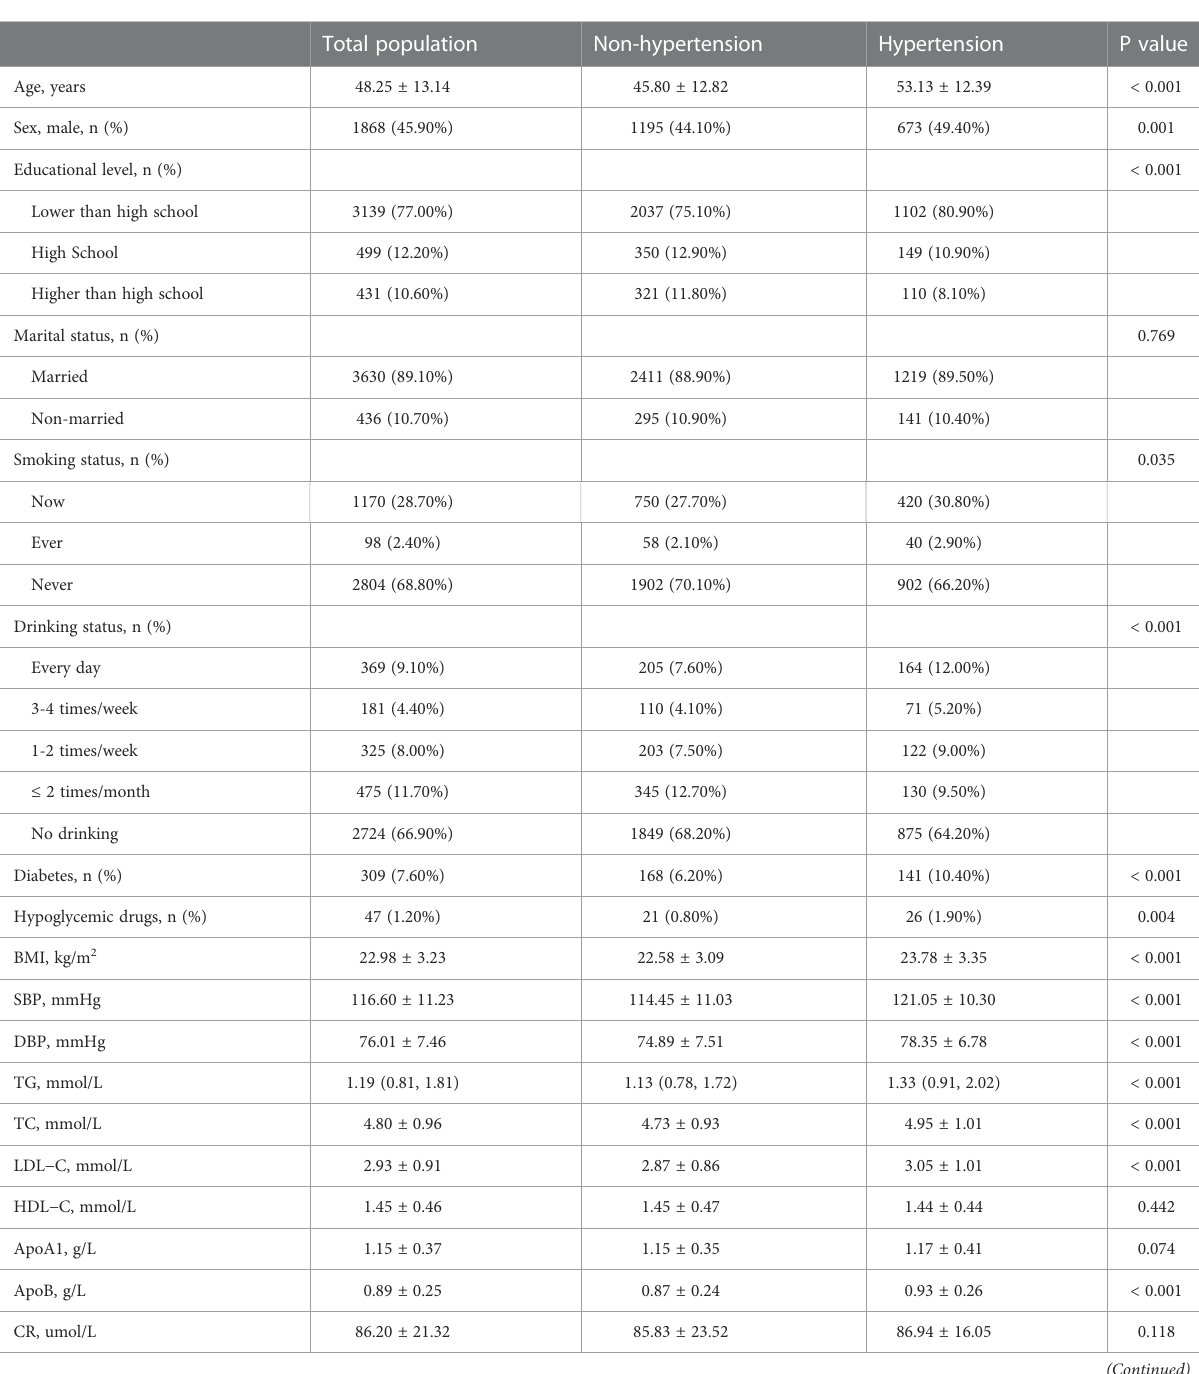
TABLE 1 Baseline characteristics of participants strati fi ed by the